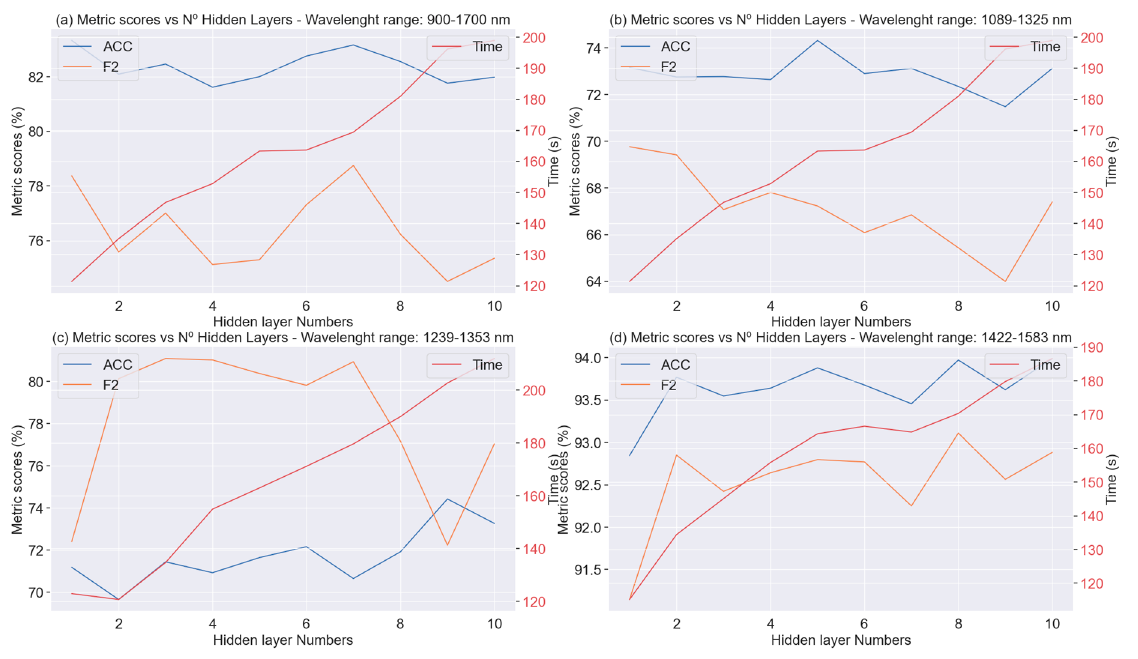
Figure 8. Accuracy, F2 ‐ Score, Training time vs. Hidden Layers.